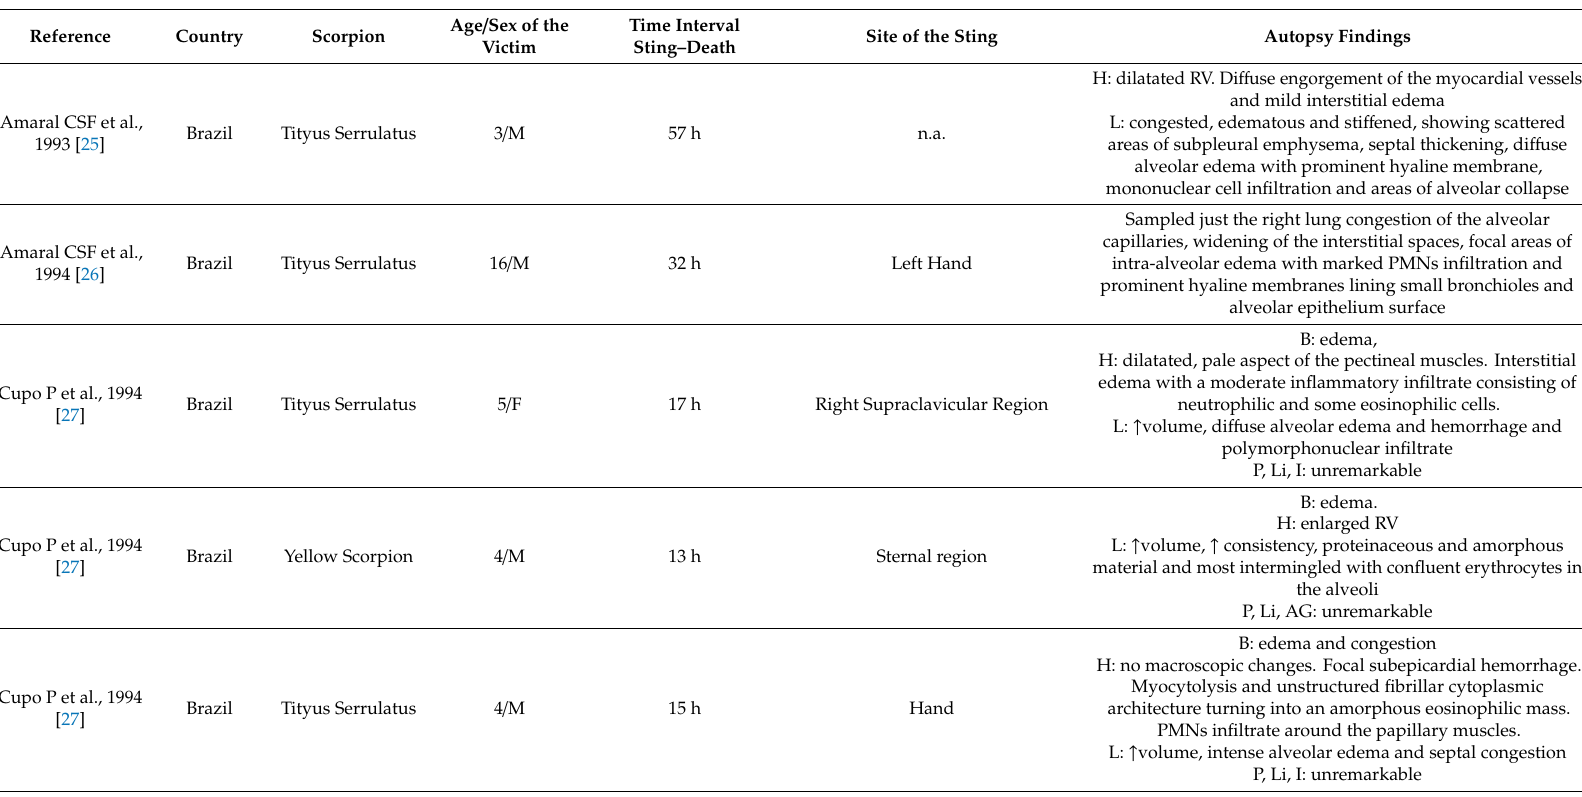
Table 1. Summary of the included papers. AG: adrenal glands; ARDS: acute respiratory distress syndrome; B: brain; H: heart; I: intestine; K: kidneys; L: lungs; LA: left atrium; Li: liver; n.a.: not available; P: pancreas; PMNs: polymorphonuclear leukocytes; RV: right ventricle; S: spleen; St: stomach; T: thymus; ↑ :